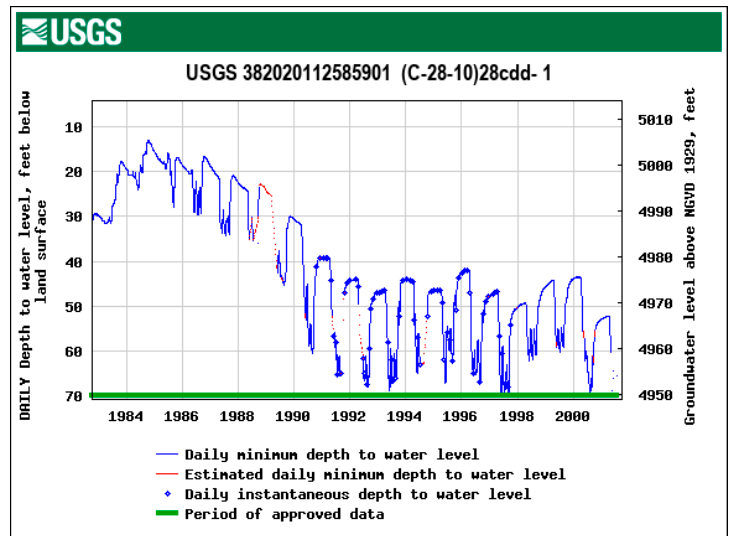
Figure 5. The daily groundwater level for USGS well 382020112585901 measured over the lifetime of this groundwater well from 1983 to 2001. This well was 790 m from the centroid of the Honey Boy Fire of August 1996.